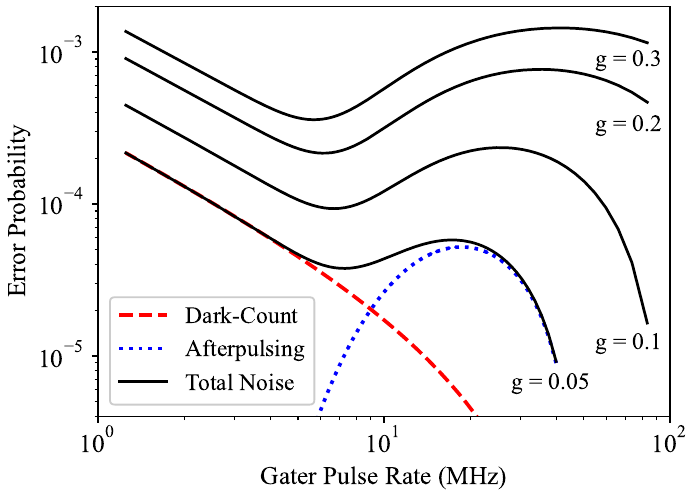
Figure 10. Noise detection probability as a function of the gated pulse rate at V ex = 3 V and different g